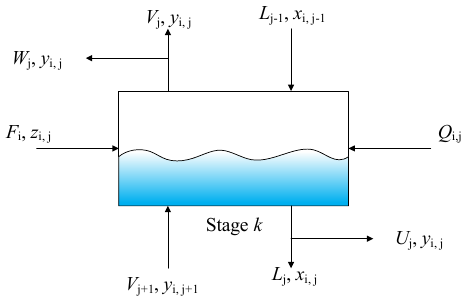
Figure 2. Schematic diagram of the theoretical stage.